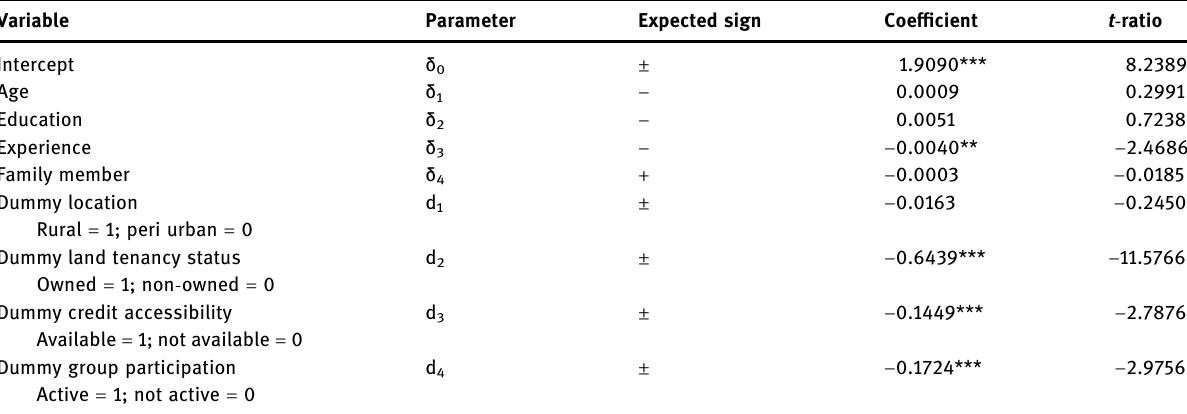
Table 6: Estimated rice farming ine ffi ciency coe ffi cients Variable